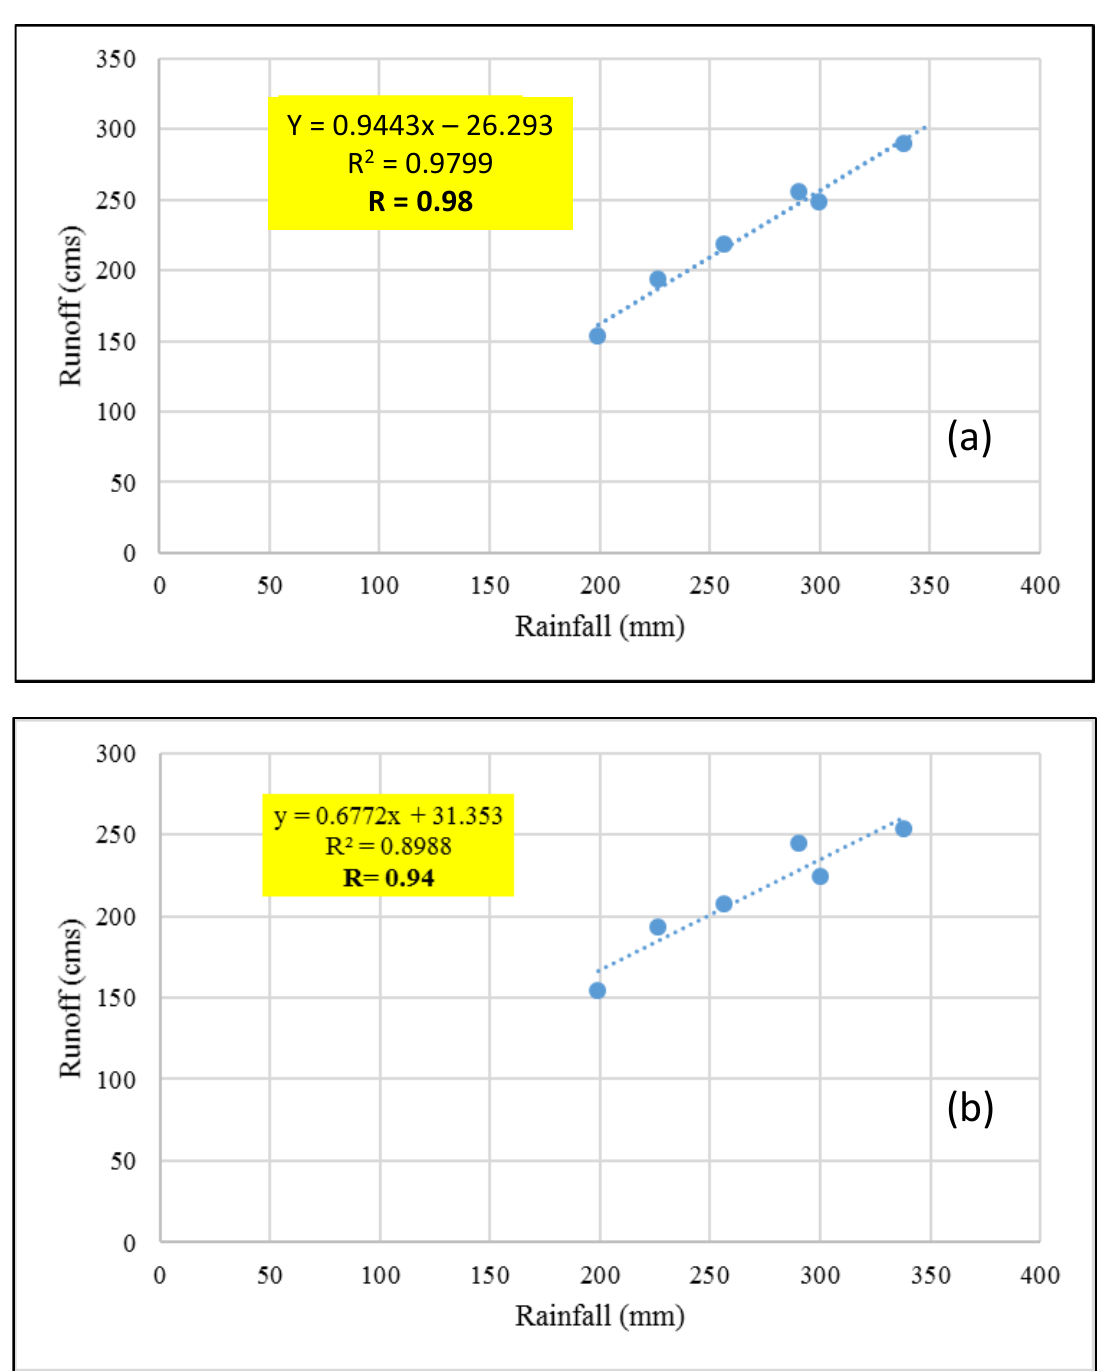
Figure 4. Rainfall runoff correlations ( a ) without infiltration facilities, and ( b ) with infiltration